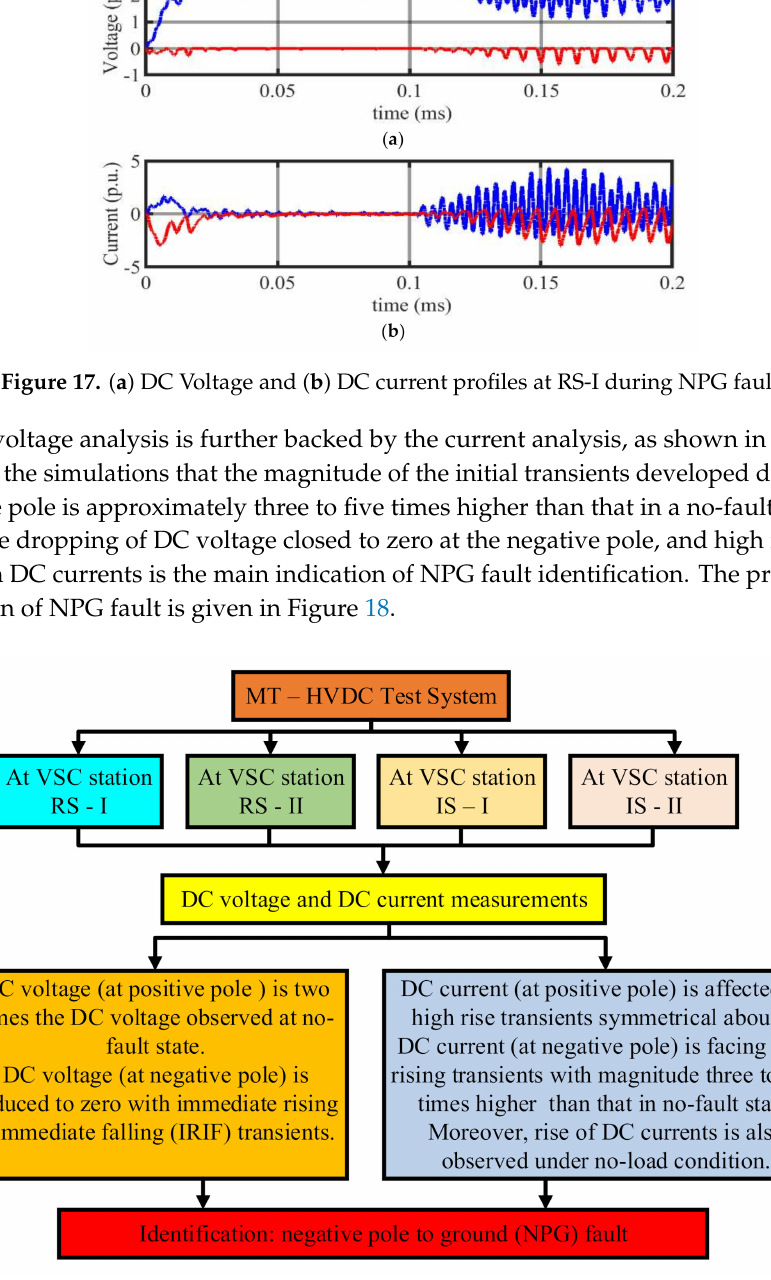
Figure 18. NPG fault identification scheme in the MT-HVDC test